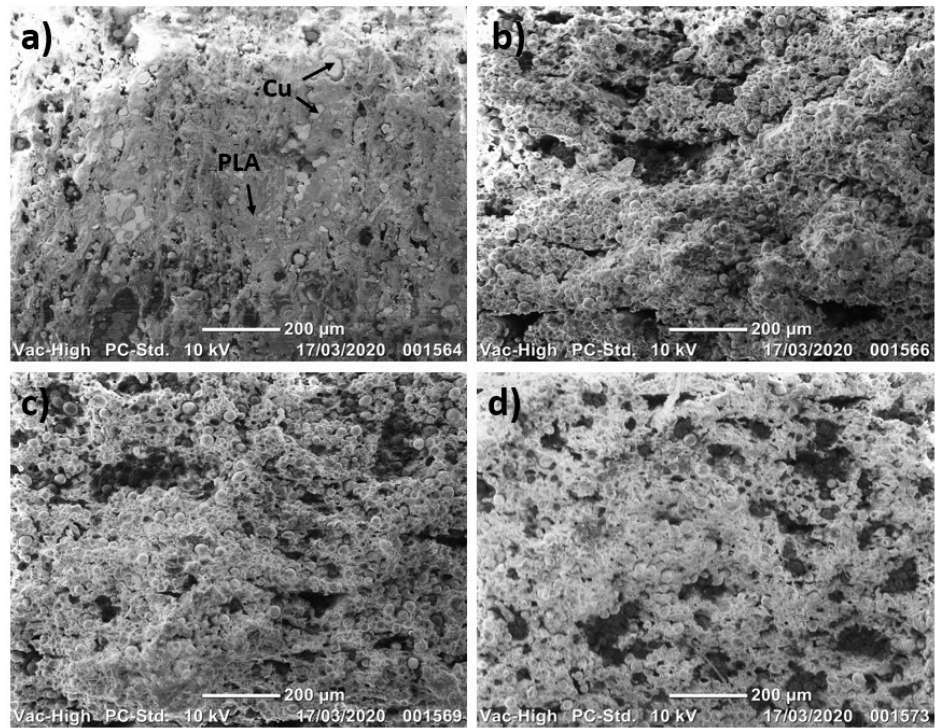
Figure 14. SEM micrographs for Cu-PLA material: ( a ) control Cu-PLA; ( b ) annealed at 70 °C; ( c ) annealed at 80 °C; ( d ) annealed at 90 °C.